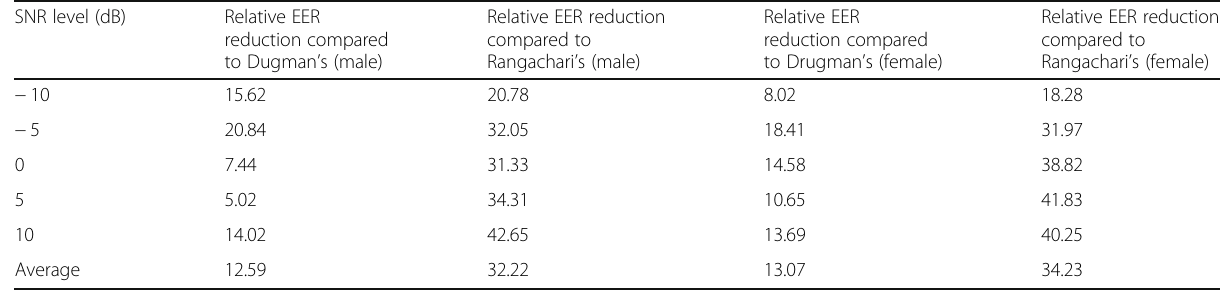
Table 3 SNR-based relative percent EER reduction rates for GMM-UBM method compared to Drugman ’ s VAD (second and fourth column) and Rangachari ’ s method (third and fifth column). Computed by averaging over all noise